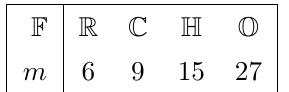
Table 3 . The normed R -algebras. m is the real dimension of Her 3 ( F